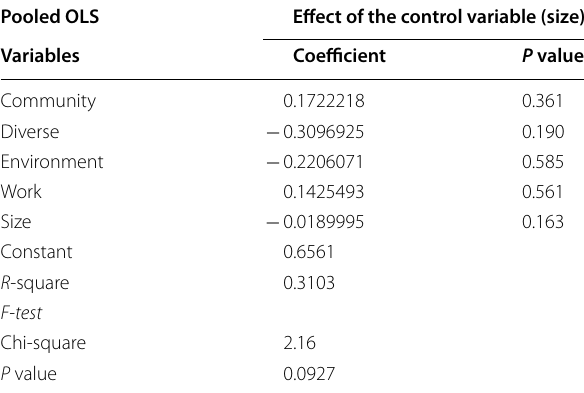
The result is evaluated based on 95% level of significance Table 7 Panel data analysis results with EPS as the dependent variable Variables Pooled